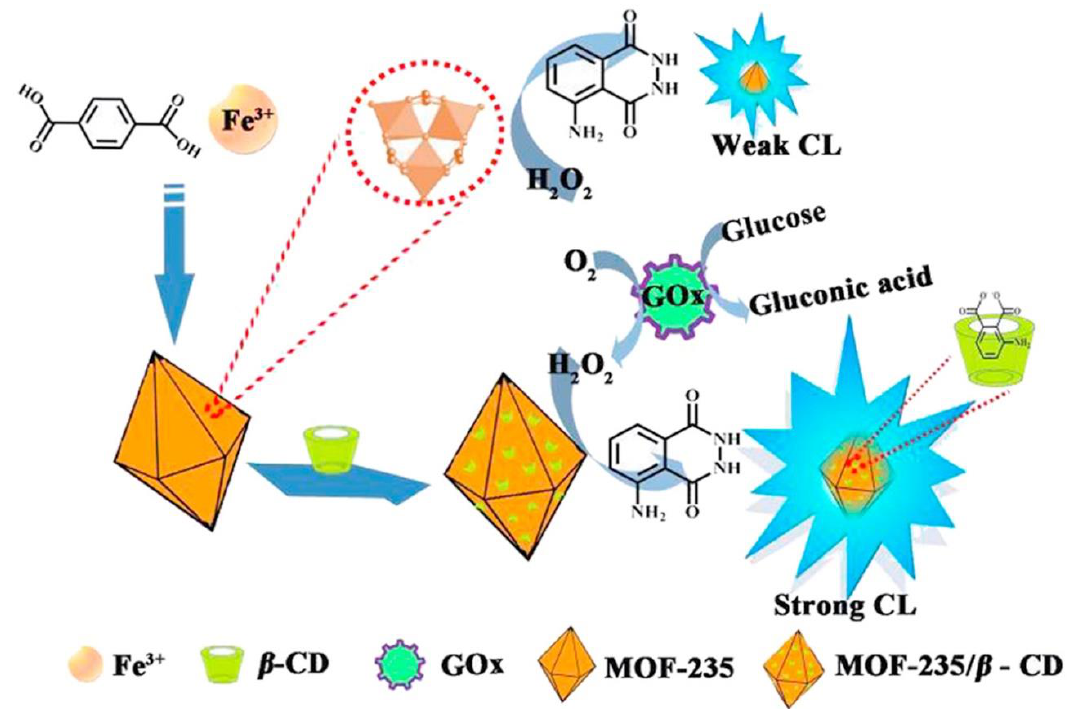
Figure 8. Proposed chemiluminescence (CL) mechanism of the luminol-H 2 O 2 system by MOF-235 / β -CDs hybrid materials. MOF-235 is generated by the coordination reaction between Fe III and terephthalic acid (top left), and further functionalized with β -CD. The intermediate of luminol is supposed to be hosted by the cavity of β -CD (right) during the oxidation reaction of glucose with glucose oxidase (GOx). Reproduced from Reference [25] with permission from Elsevier B.V. Copyright 2018.